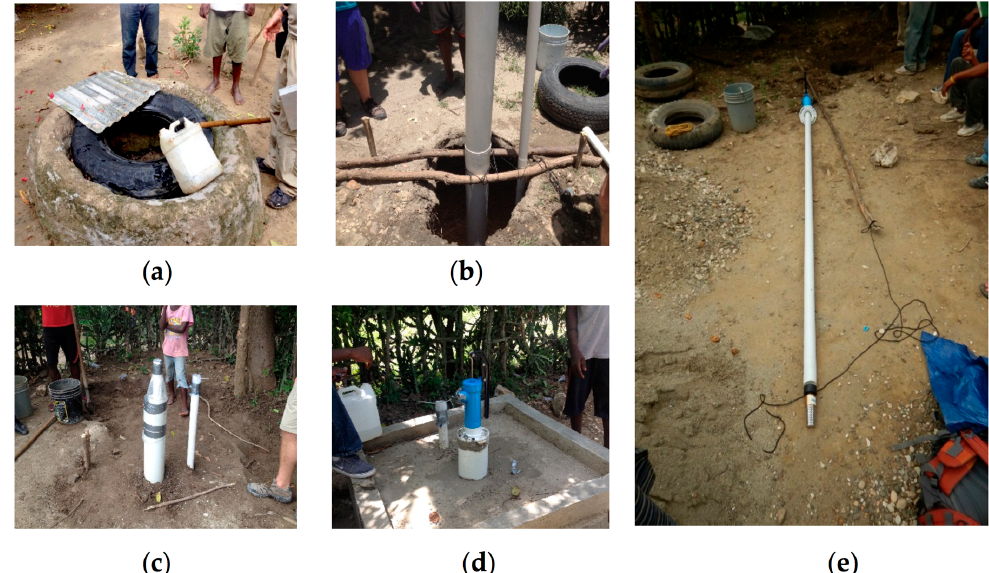
Figure 10. ISF well conversion process materials: ( a ) initial hand–dug well; ( b ) installation of PVC casing; ( c ) sand pack addition; ( d ) final ISF well product with a concrete collar; ( e ) internal ISF well components including a pump head, PVC casing, and check valve.